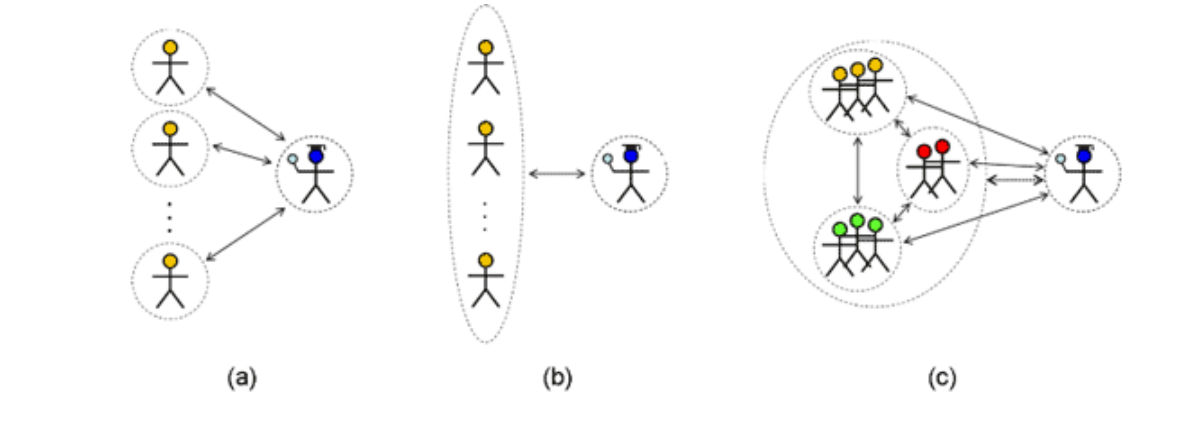
Fig. 6. Different ways of involving potentially heterogeneous actors in participatory